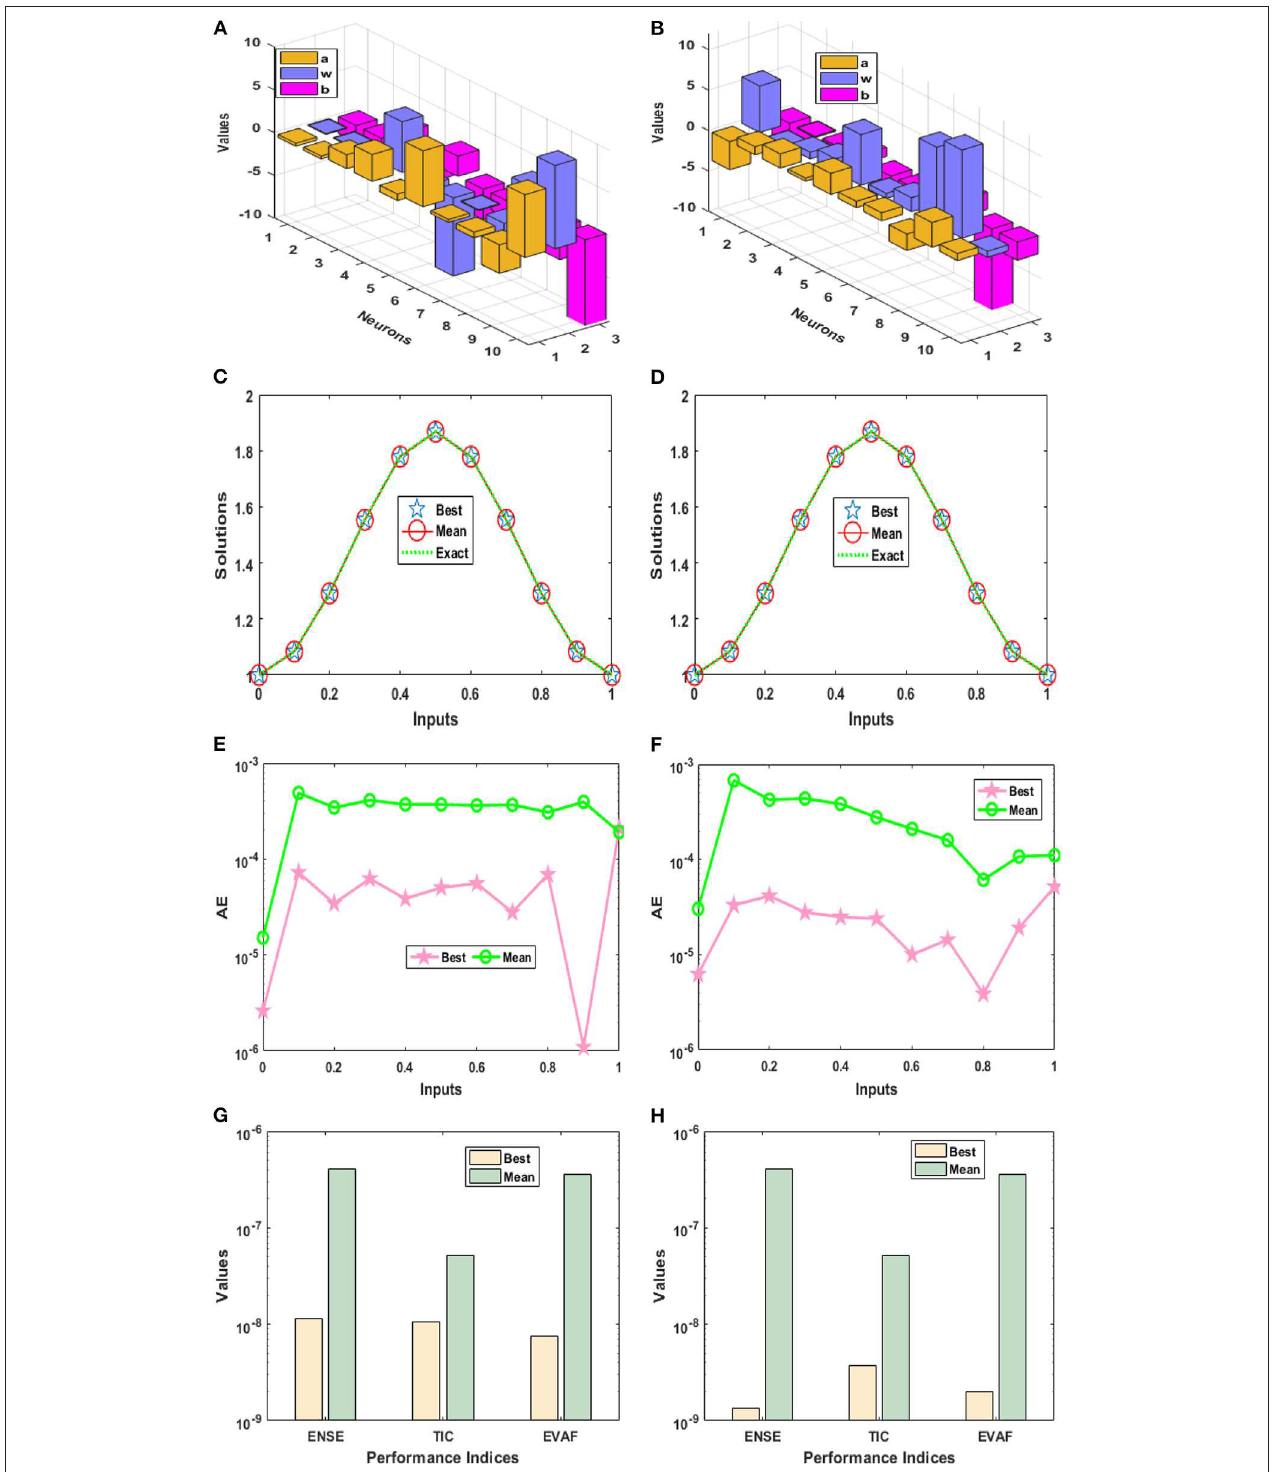
FIGURE 2 | Best weight, results of the designed methodology, values of the AE, and performance measures of Examples 1 and 2 for 10 numbers of neurons. (A) ANN best weights for Example 1. (B) ANN best weights for Example 2. (C) Result comparison for Example 1. (D) Result comparison for Example 2. (E) AE values of 10 neurons for Example 1. (F) AE values of 10 neurons for Example 2. (G) Performance measures for Example 1. (H) Performance measures for Example 2.